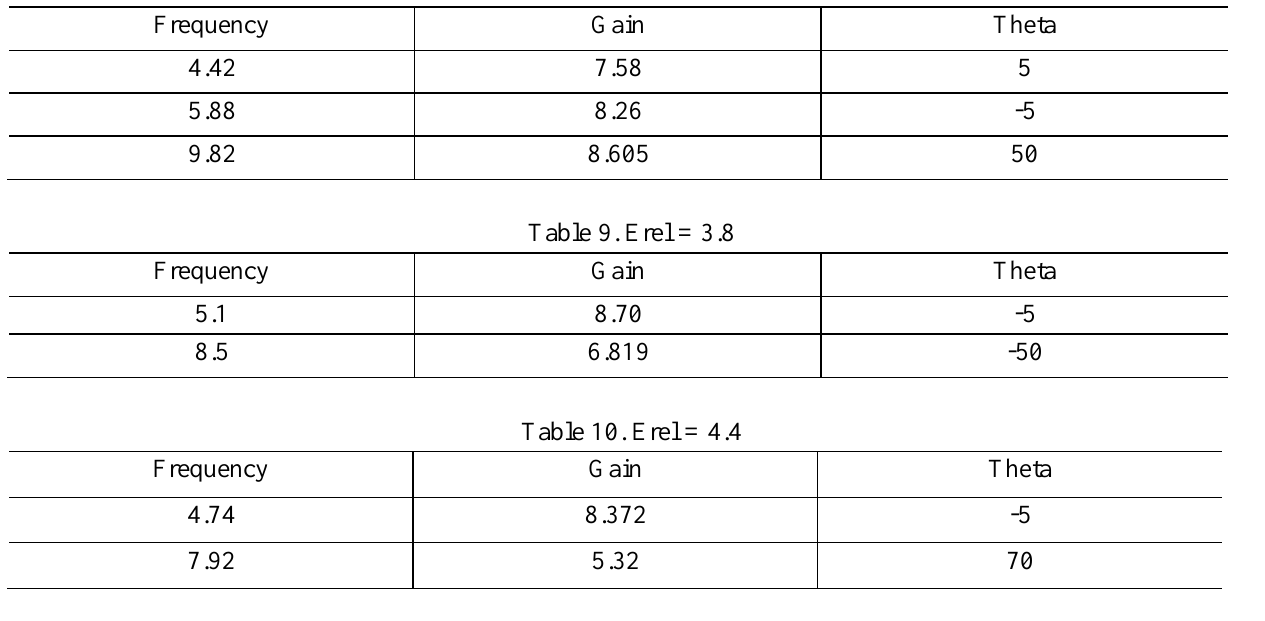
Table 8. Erel = 2.8